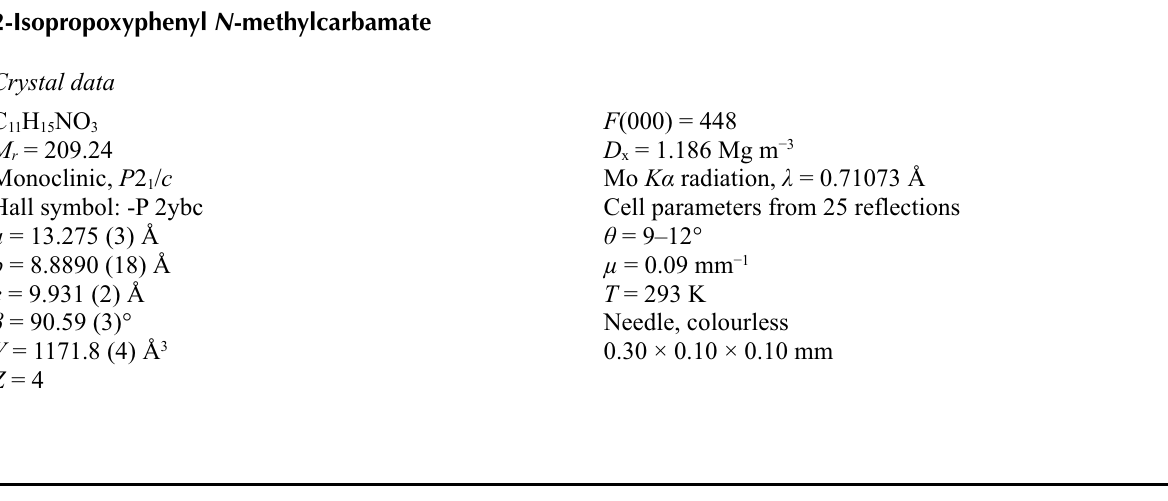
A view of the title compound with the atomic numbering scheme. Displacement ellipsoids were drawn at the 30% probability